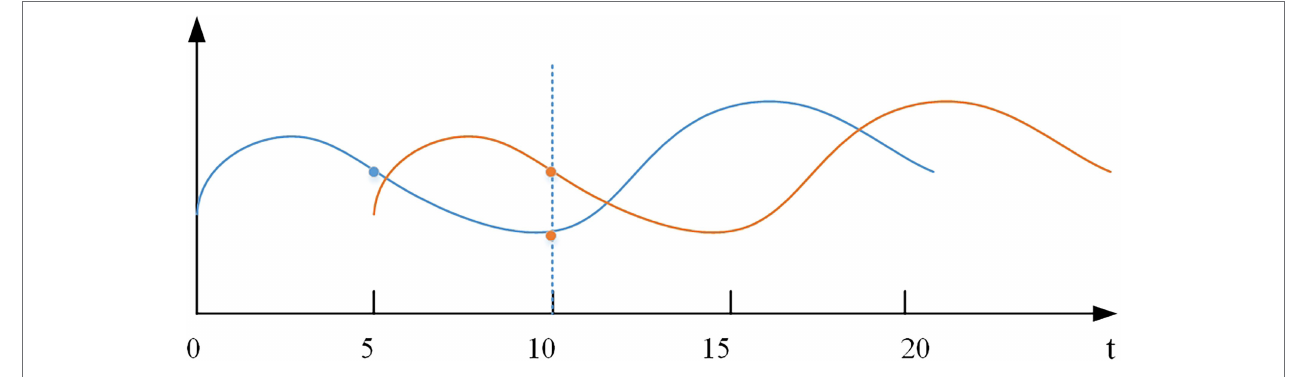
FIGURE 6 | Time shift issue of time